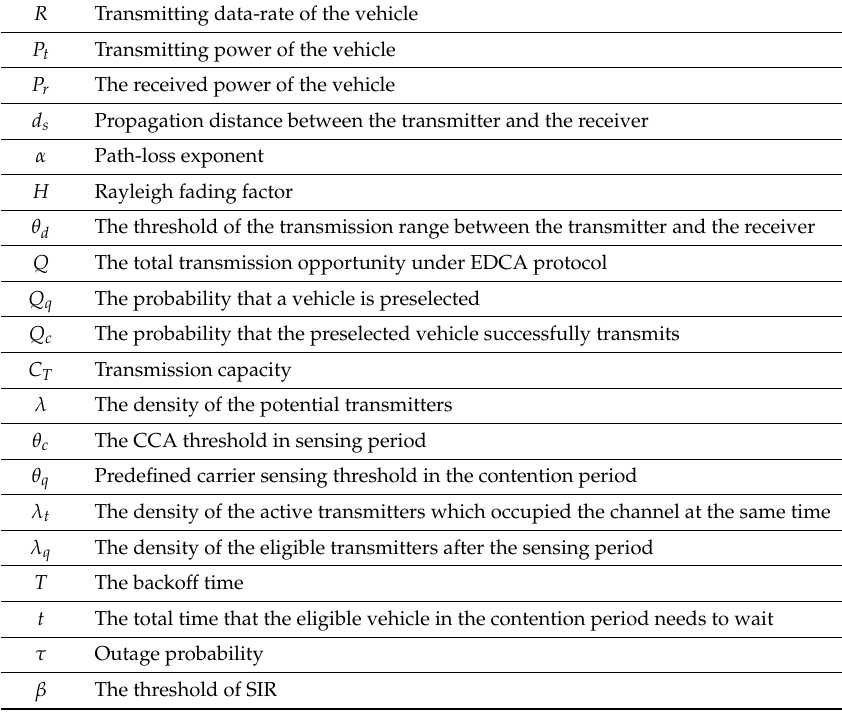
Table 1. Summary of